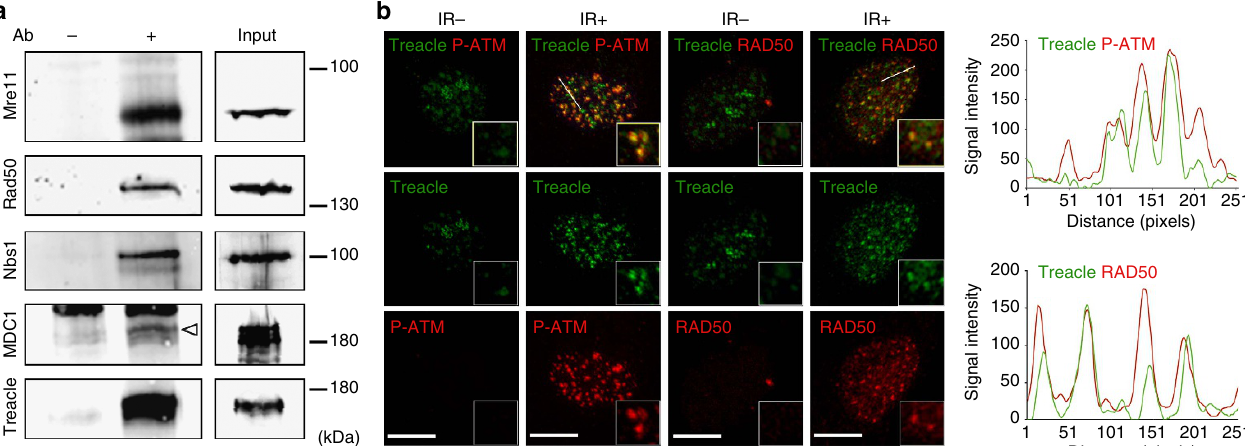
Figure 1 | Treacle interacts with Mre11–Rad50–Nbs1–MDC1 complex and localizes to DNA damage-induced foci. ( a ) Interaction between endogenous Treacle and endogenous Mre11, Rad50, Nbs1 and MDC1 were detected by immunoprecipitation with ( þ ) or without ( (cid:2) ) anti-TCOF1 antibody. Proteins in the immunoprecipitated fraction were detected using antibodies to the proteins indicated on the left side. Arrowhead indicates a band of MDC1. ( b ) Immunofluorescence images of HeLa cells with (IR þ ) or without (IR (cid:2) ) X-ray irradiation. DNA damage-induced foci within nucleus were confirmed by co-immunostaining of anti-phosphorylated ATM (P-ATM), anti-RAD50 and anti-Treacle antibodies. Higher magnification images are shown as insets. Scale bar, 5 m m. Plot profiles show signal intensities along an oblique line quantified by ImageJ (five independent experiments and one representative image